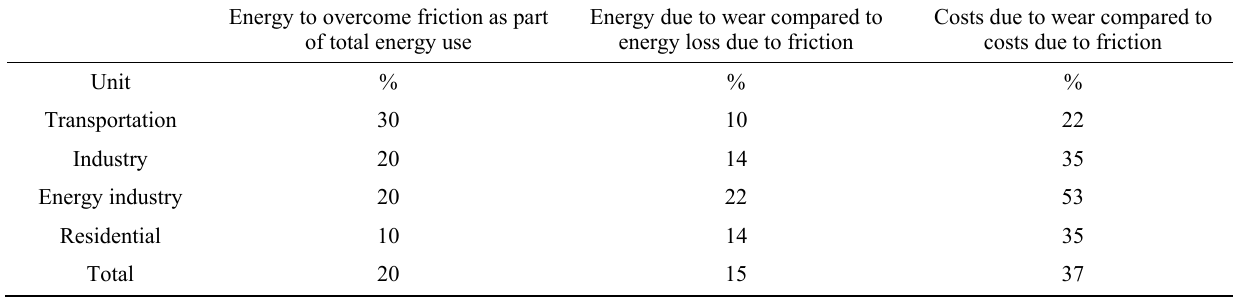
Table 1 Comparison of energy and costs due to friction and wear for the four economic sectors. Energy to overcome friction as part of total energy use